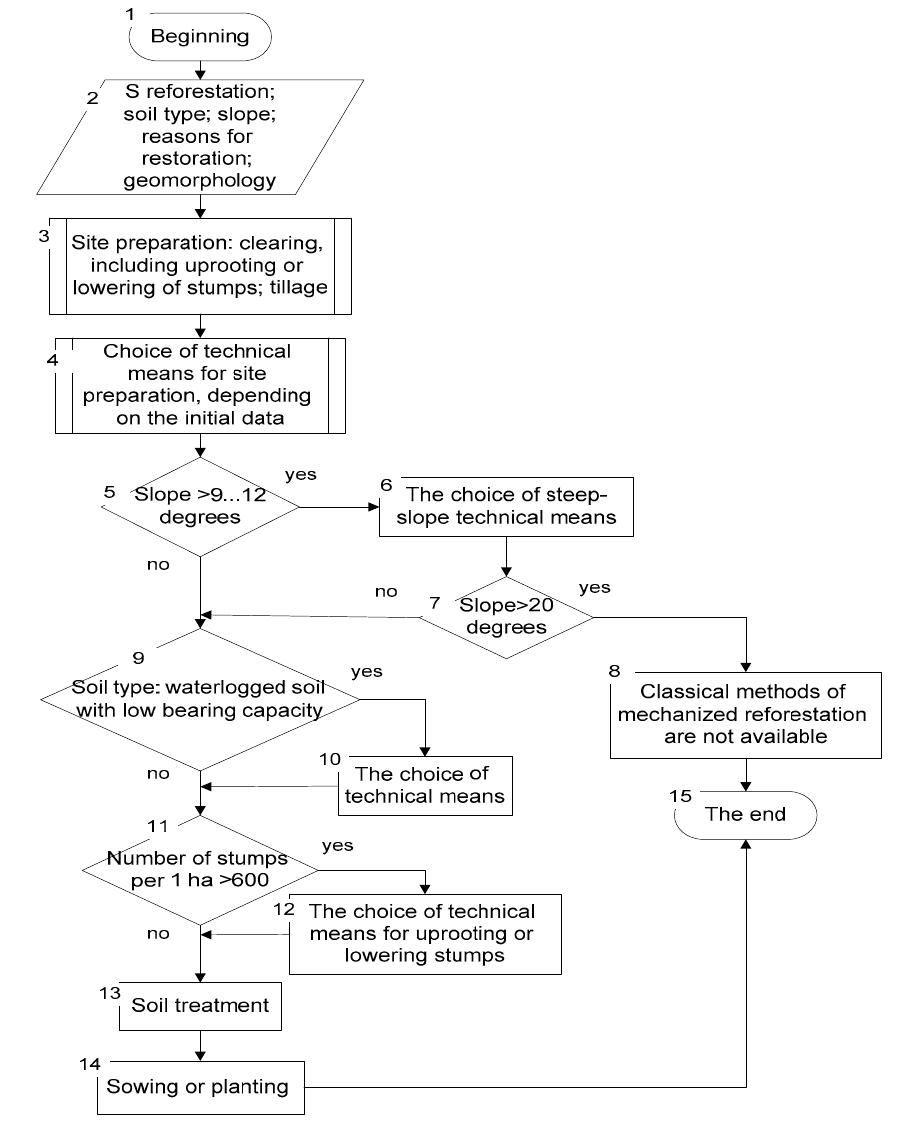
Figure 1. An algorithm using classical FLR technology. Adapted from [58].